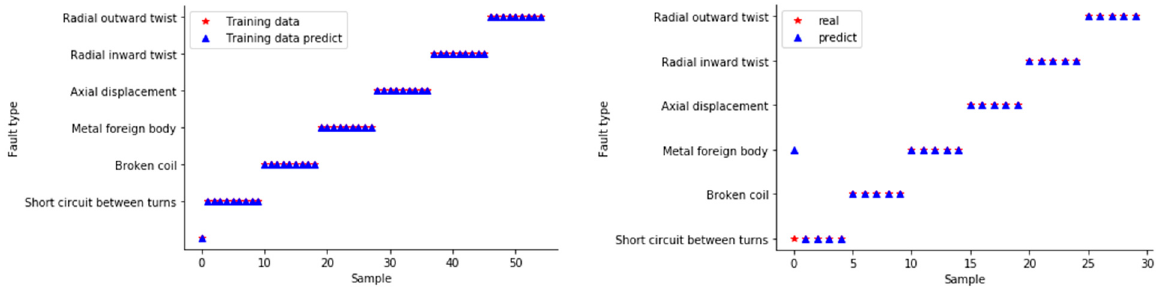
Figure 8. Classification performance of the model on the data set.